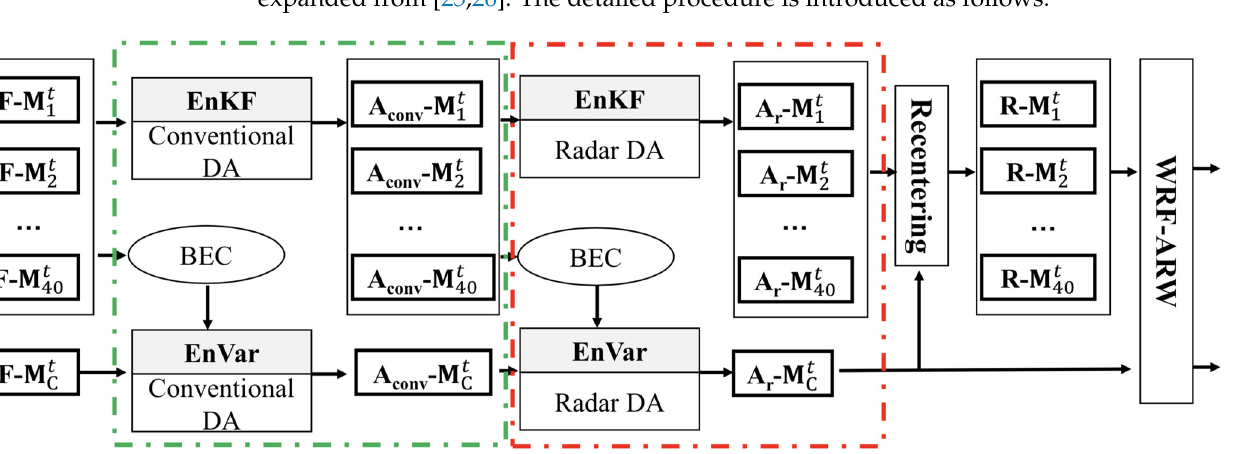
160 Figure 2. The model domain for the EDA system. The E-W scale of the domain is ~4860km, the N- 161 S scale of the domain is ~3360km, and latitude/longitude dashed lines are overlaid for reference. 162